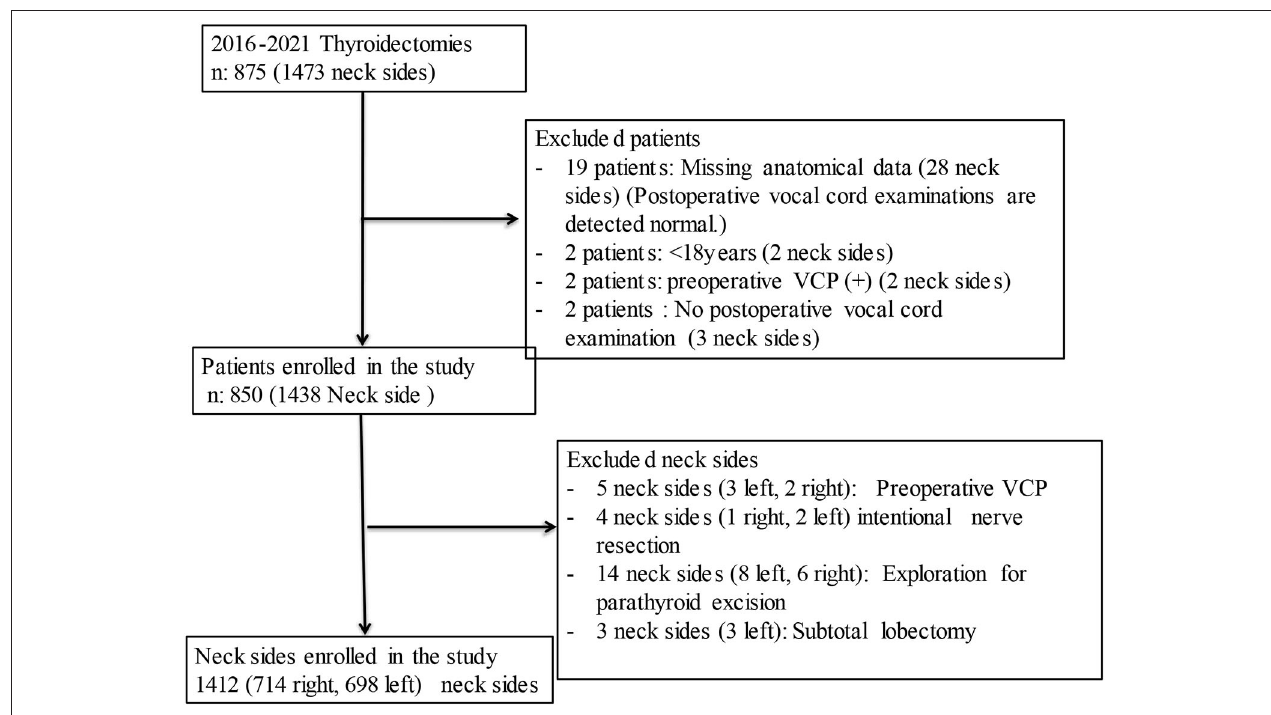
FIGURE 1 | Flow diagram of the patients enrolled in the study.